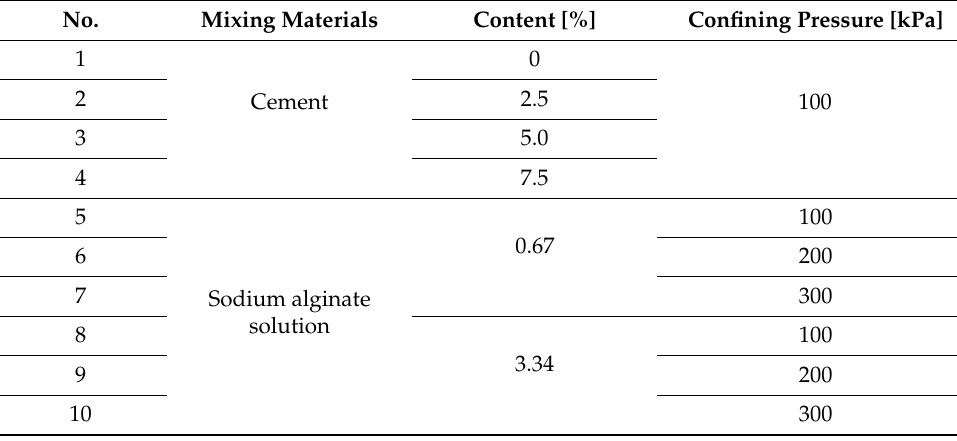
Figure 3. Experimental setup for resonant column test of a soil sample. Table 3. Specimens in resonant-column